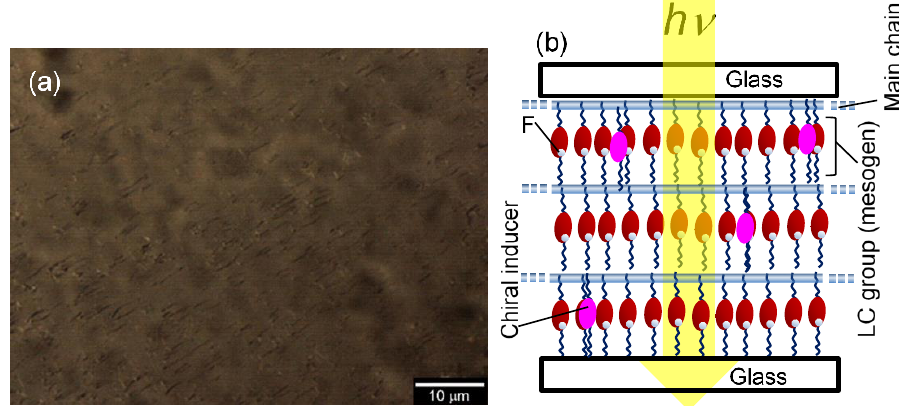
Figure 9. The POM image of ( a ) the pseudo-homeotropic-oriented (i.e., the vertical orientation against the glass cell surface) section of the SmC*–LC–poly(Ac–Pyr) blend with the chiral inducer. ( b ) Homeotropic alignment.